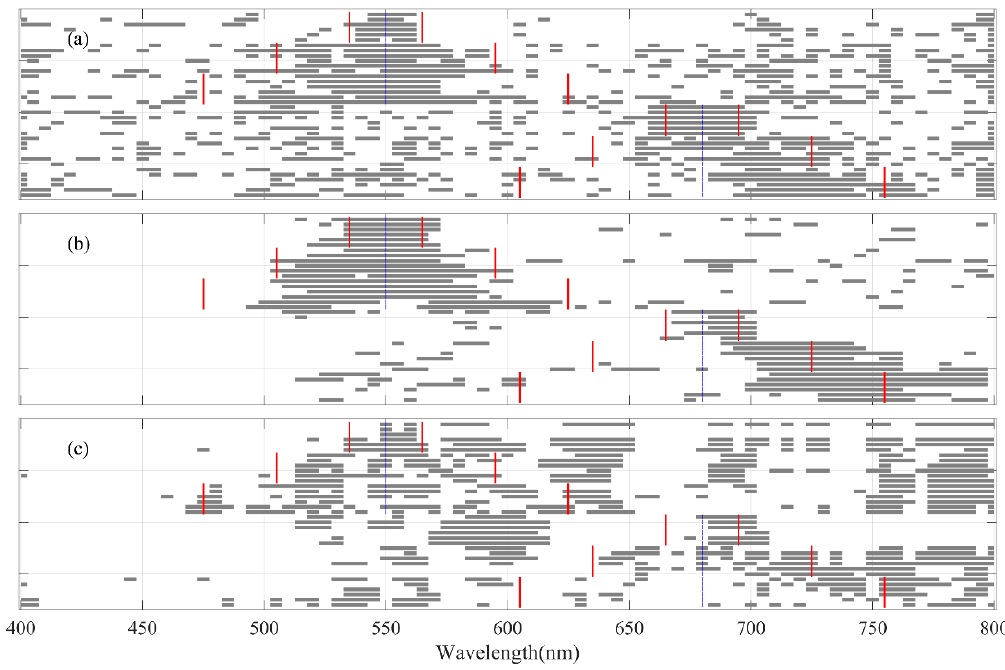
Figure 4. Bands involved in stepwise-PLS ( a ), genetic algorithms (GA-PLS) ( b ), and uninformative variable elimination method (UVE-PLS) ( c ) models for C d estimation. The blue lines are the absorption peak locations of C d (only results of 550 nm and 680 nm are presented). The red lines are the absorption boundaries of C d . For one fixed absorption peak location and half-width, the selected bands for PLS estimation of C d with six absorption intensities were in sequence.